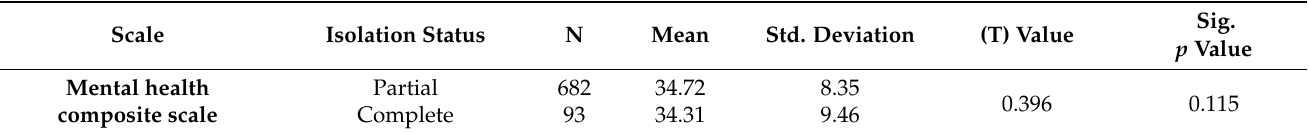
Table 4. Statistical differences between participants’ isolation statuses and mental health (N = 775).